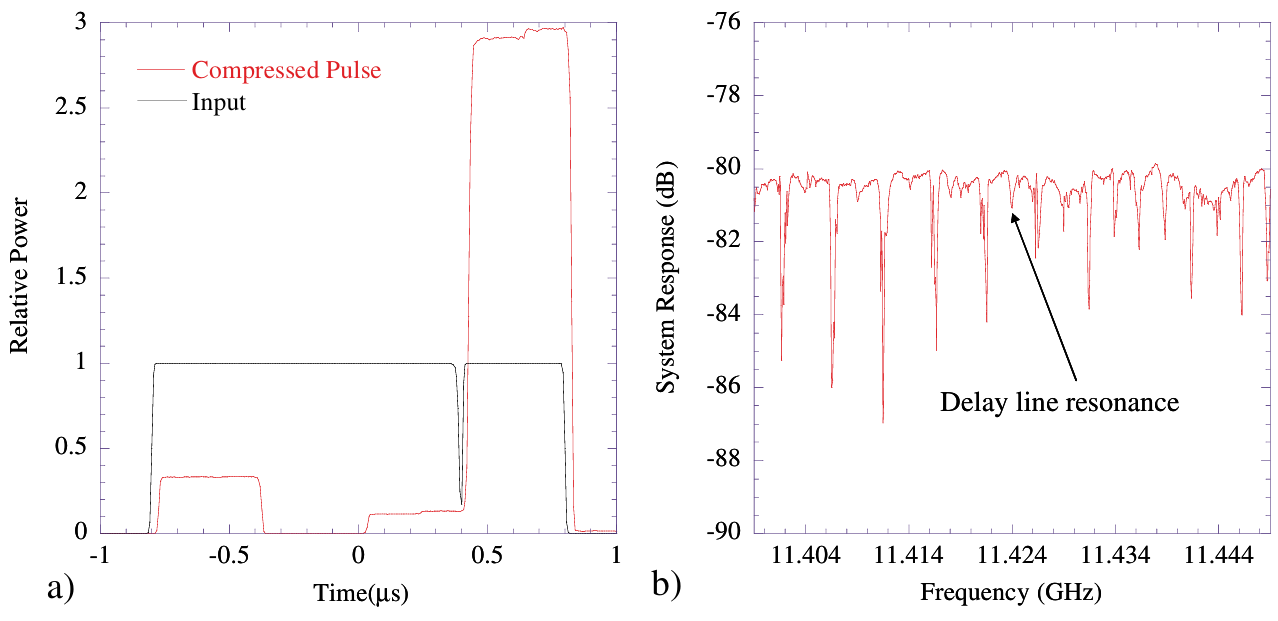
FIG. 21. (Color) Final system response.